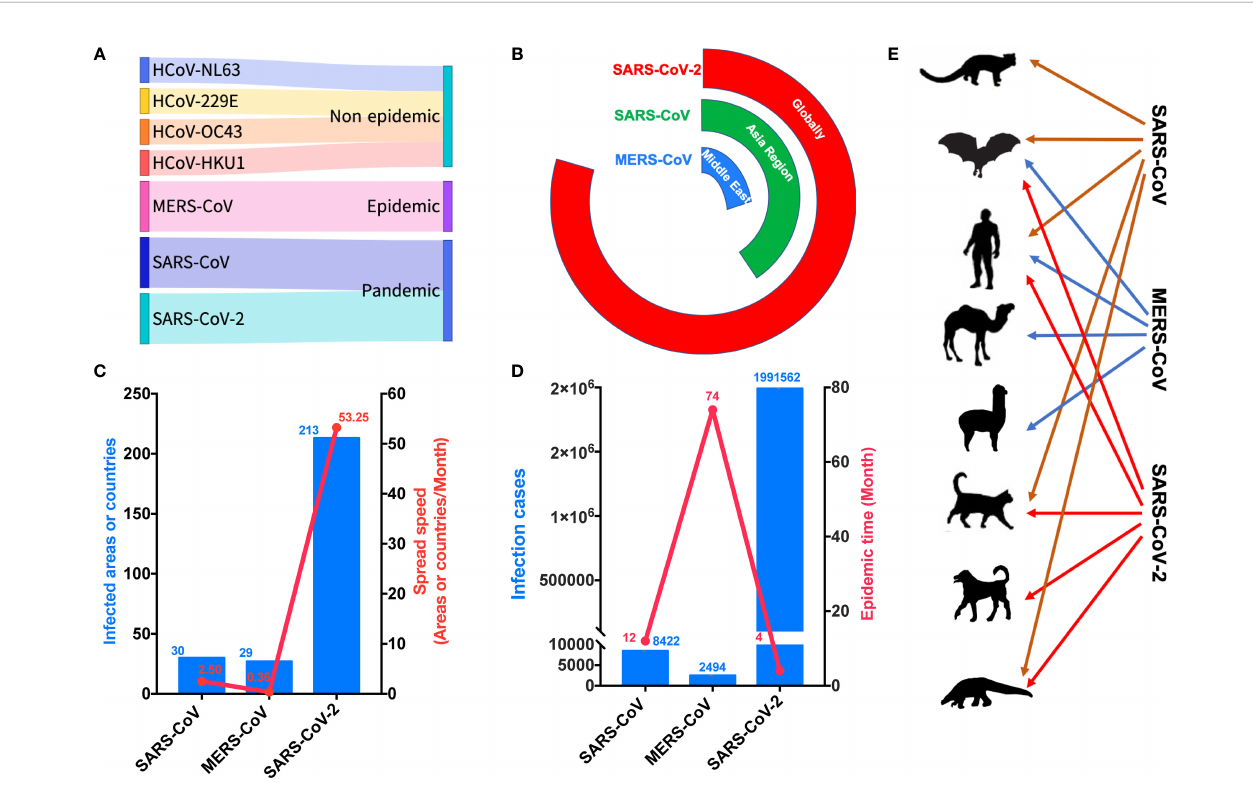
FIGURE 1 | COVID-19 is creating the worst global pandemic. (A) Seven coronaviruses that can infect humans have led to different epidemic consequences. (B) SARS-CoV-2 sparked a global pandemic. (C) SARS-CoV-2 was associated with infection in the highest number of countries and exhibited the highest speed of transmission. (D) SARS-CoV-2 infected the largest number of people in the shortest time. (E) SARS-CoV-2 infected speci fi c animals that come in close contact with humans. HCOV-NL63, human coronavirus NL63; HCOV-299E, human coronavirus 299E; HCOV-OC43, human coronavirus OC43; HCOV-HKU1, human coronavirus HKU1; MERS-CoV, Middle East respiratory syndrome coronavirus; SARS-CoV, Severe acute respiratory syndrome coronavirus. SARS-CoV-2, Severe acute respiratory syndrome coronavirus